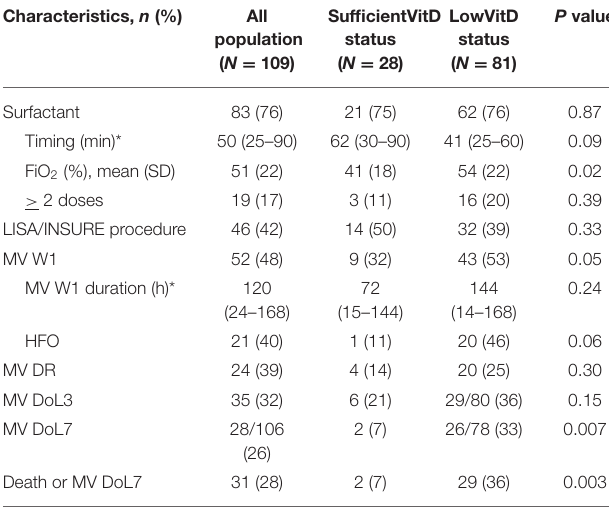
TABLE 1 | Obstetrical and neonatal characteristics according to vitamin D status at birth. Characteristics, n (%) All population